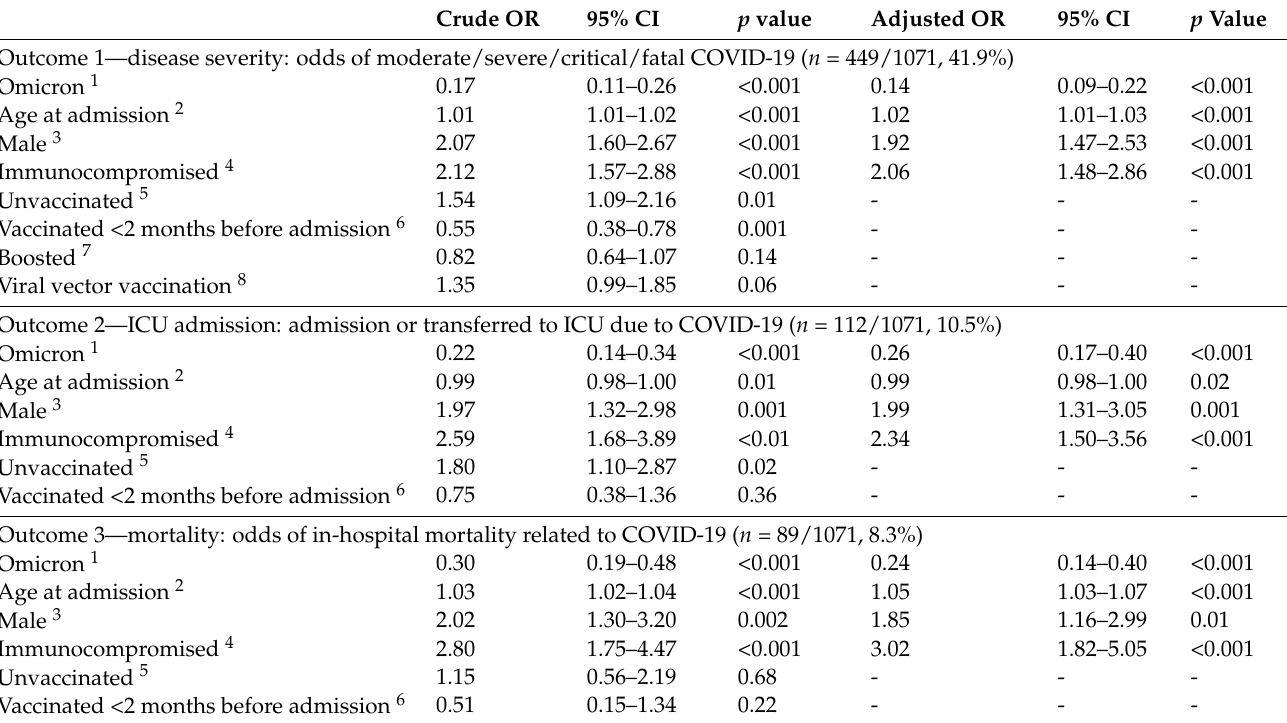
Table 1. Mixed-model logistic regression analysis comparing severity of COVID-19 outcomes between hospitalized adult patients infected with Delta ( n = 166) and Omicron ( n = 905) (excluding patients with untyped VOC, n = 210). Covariates: 1. versus Delta; 2. odds increase per year; 3. versus female; 4. versus non-immunocompromised; 5. versus any vaccination; 6. versus unvaccinated or